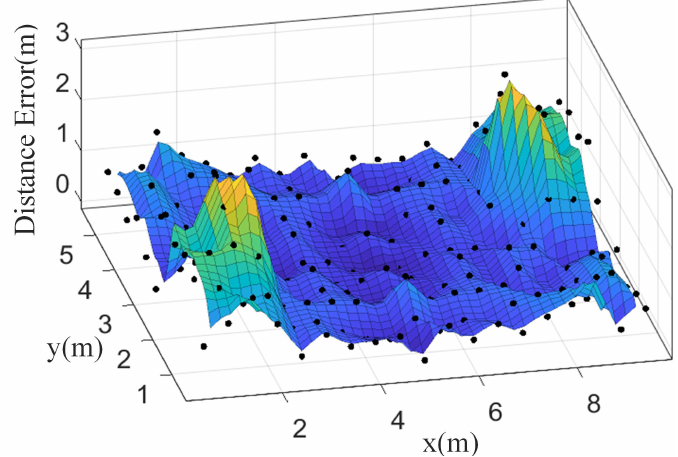
Figure 6. Positioning Error